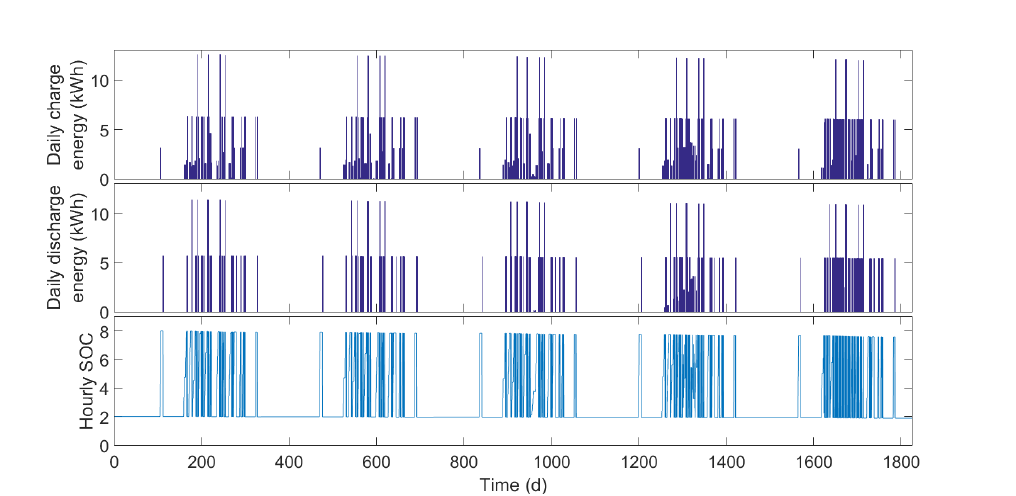
Figure 8. Optimal operation for a “complex tariff” example during a five years period and a battery price of 250 USD/kWh. Notice how battery operation is concentrated towards the end of the simulation period. Table 3. Electricity annual savings and annual capacity loss for each operation year with complex